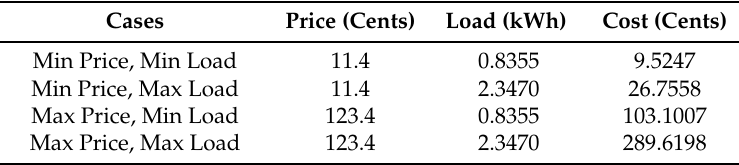
Table 14. Possible Cases: OTI 30-min using CPP.